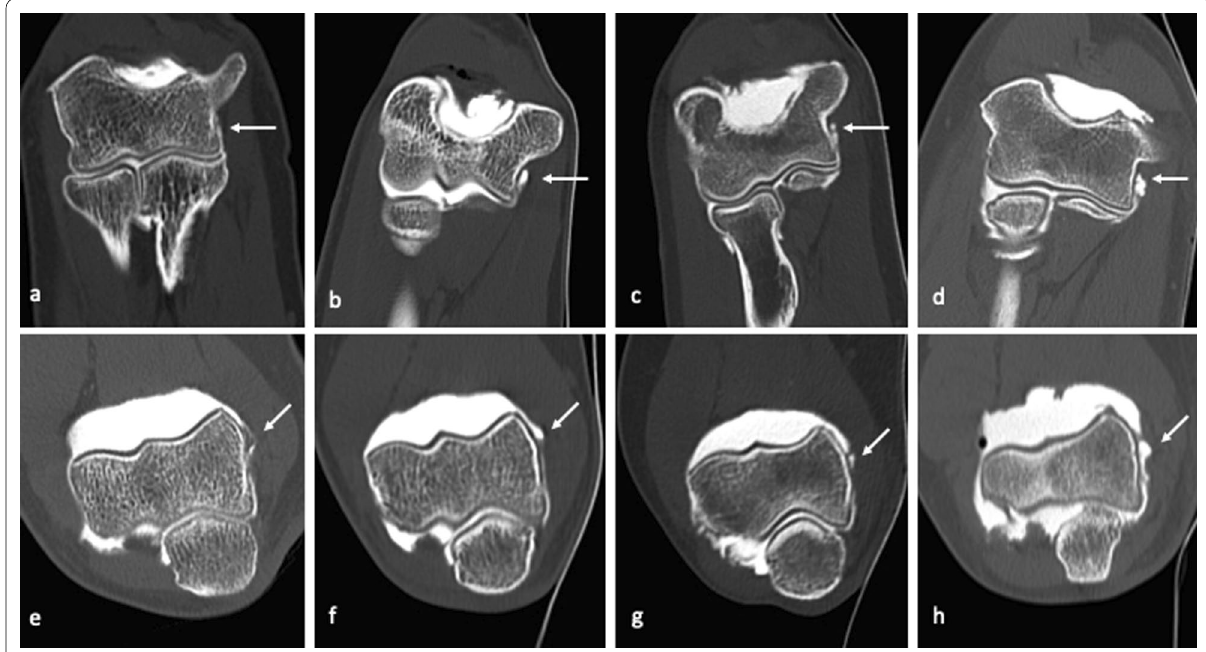
Fig. 5 CT-arthrography coronal images ( a – d ) and axial images ( e – h ) belonging to four different patients, three of which display different aspects of ligament derangement involving the A-MCL (white arrows). Intact anterior band (A-MCL) of the medial collateral ligament (MCL) complex ( a , e and b , f ). Widening of the medial aspect of the articular recess, associated to a “bow-shaped” loose A-MCL, with no evidence of fiber tearing, suggestive of ligament laxity ( b , f ). Thickened and irregular A-MCL, showing a partial-thickness tear ( c , g ) and a full-thickness tear ( d , h ); contrast agent progressively spills through the ligament, as fibers are gradually disrupted as a consequence of micro-tearing and damage progresses from a partial to a complete